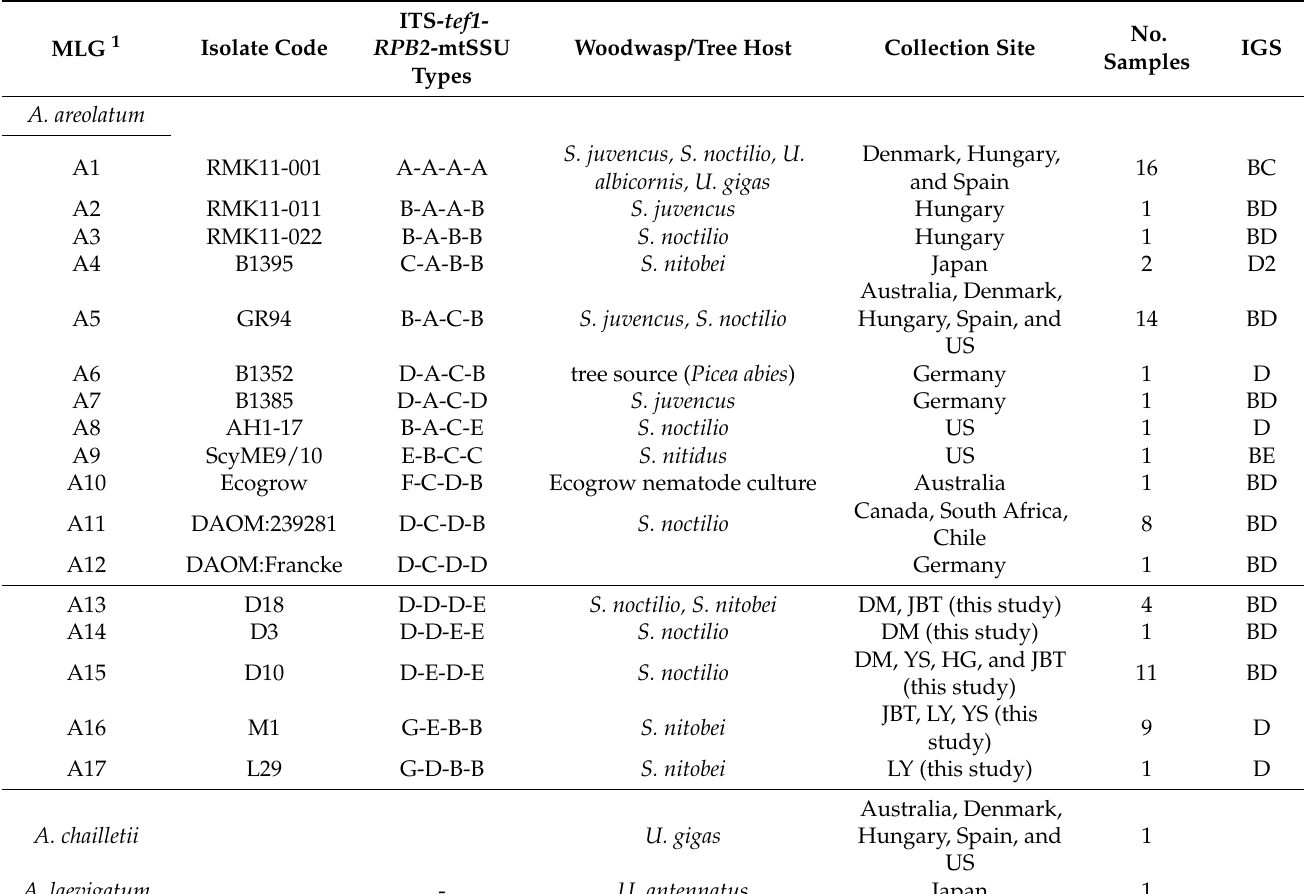
Table 3. Multilocus genotypes based on ITS, mtSSU, RPB2 , and tef1 sequence data of Amylostereum areolatum from Sirex spp. and Urocerus spp. from various countries and sites.